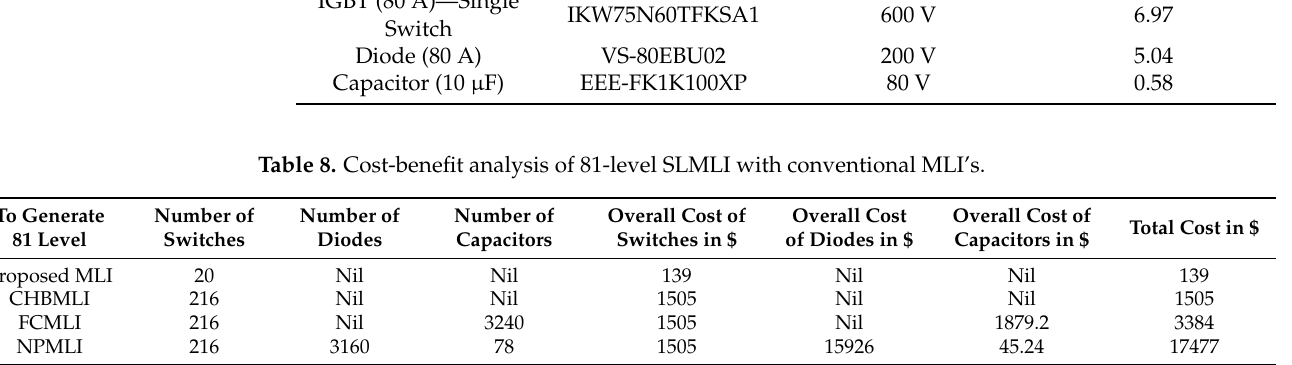
Table 8. Cost-benefit analysis of 81-level SLMLI with conventional MLI’s.